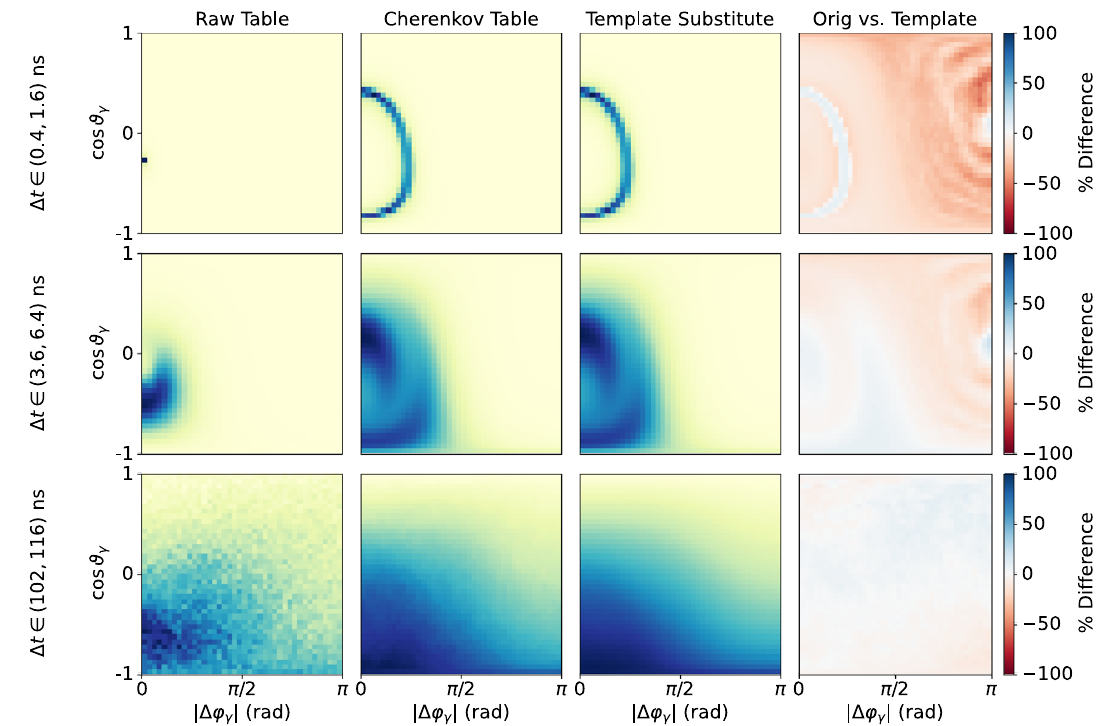
Fig. 11 Example retro table slices showing the photon directions for (cid:5) t bins (0.4, 1.6), (3.6, 6.4), and (102, 116)ns from top to bottom, at r -bin (7, 8)m and cos ϑ -bin (0.25, 0.3). The left column shows the photon direction distribution from emitted photons, the second column has the Cherenkov-cone folding applied, the third column shows the template substitute, and the last column shows the error introduced by the template compression. The distributions in the first three columns are normalized, and darker areas indicate higher photon density (linear Fig. 12 Slices through the likelihood landscape, with the remaining six event parameters set to truth in each panel. The white star indicates the maximum likelihood point within the slice. The true values (shown as black crosshairs) for the depicted ν CC μ example event are V xyzt = (8.0m, 47.2m, -346.9m, 9660ns), (ϕ,ϑ) = (1.65, 1.77)rad, and deposited energies ( E cscd , E trck ) = (14.3, 4.2)